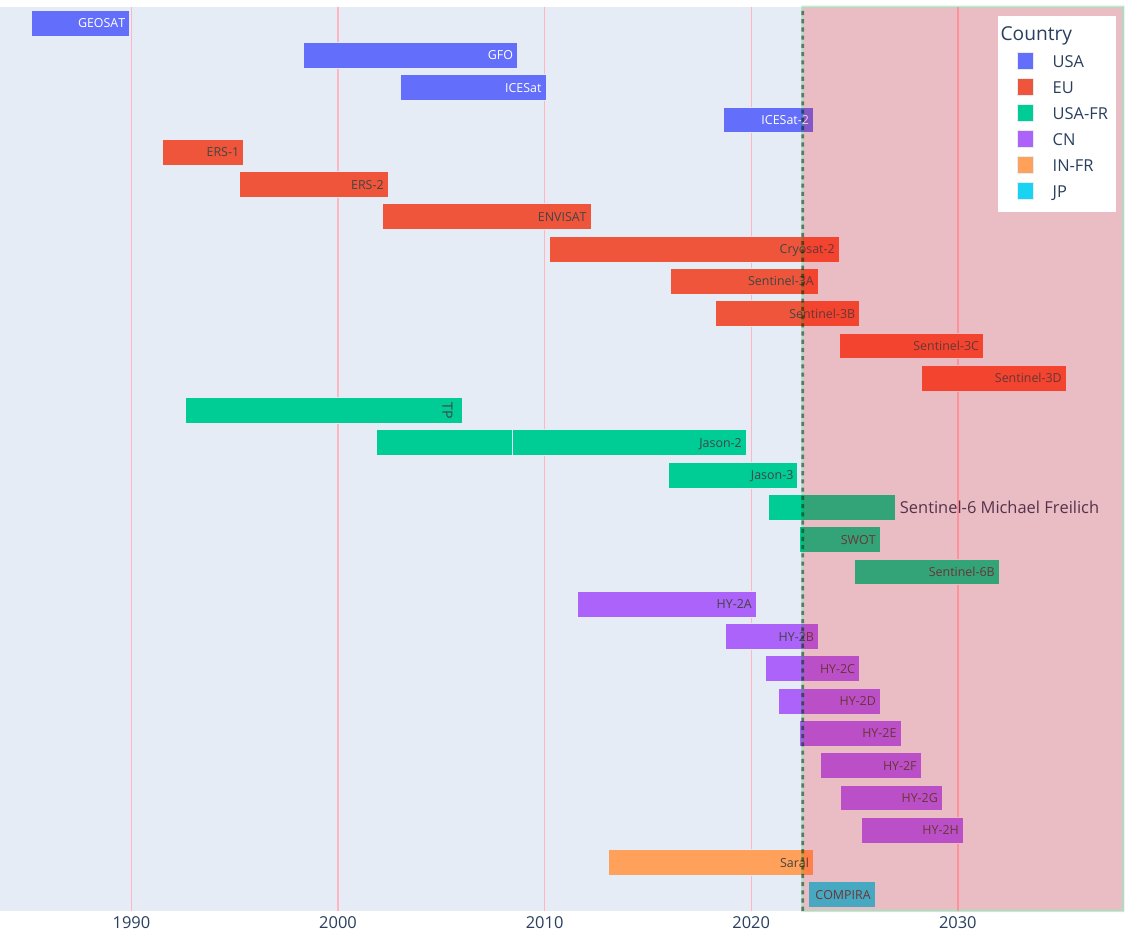
Figure 1. Gantt chart showing the past, present, and future altimetry missions since 1985. The current date of 1 July 2022 is depicted by the dashed gray line. Satellite information was provided by https://space.oscar.wmo.int (accessed on 4 April